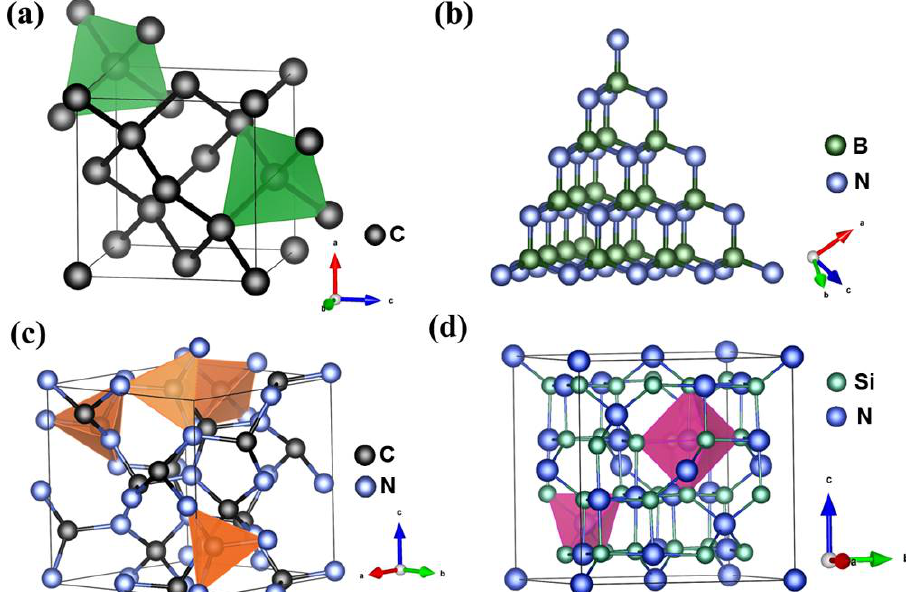
Figure 1. Crystal structures of ( a ) diamond, ( b ) cBN, ( c ) cubic C 3 N 4 (I-43d, ICSD 83263), and ( d ) γ-Si 3 N 4 (cubic phase, Fd3m, ICSD 97566), all of which are characterized by short and strong sp 3 covalent bonds constituting a three-dimensional network of high-symmetry with a high atomic density. For these materials, carbon atoms are shown in black, boron atoms in green-gray, nitrogen atoms in blue, and silicon atoms in green.